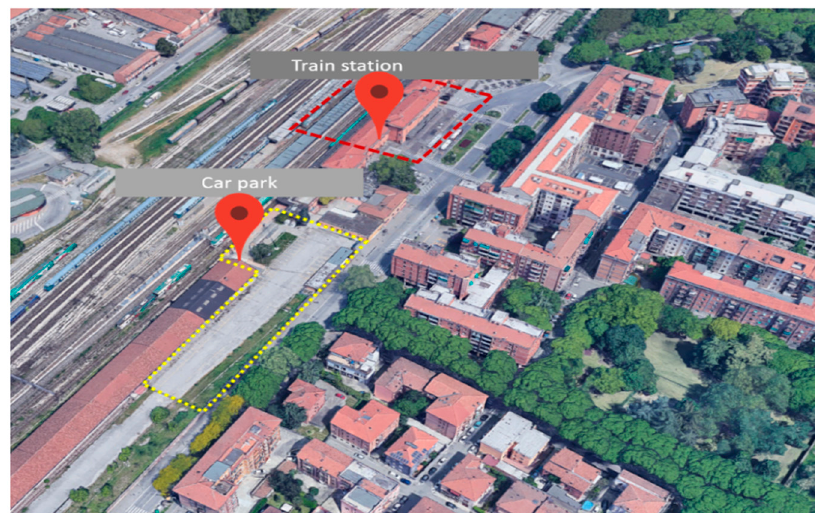
Figure 2. Top view of the parking lot.